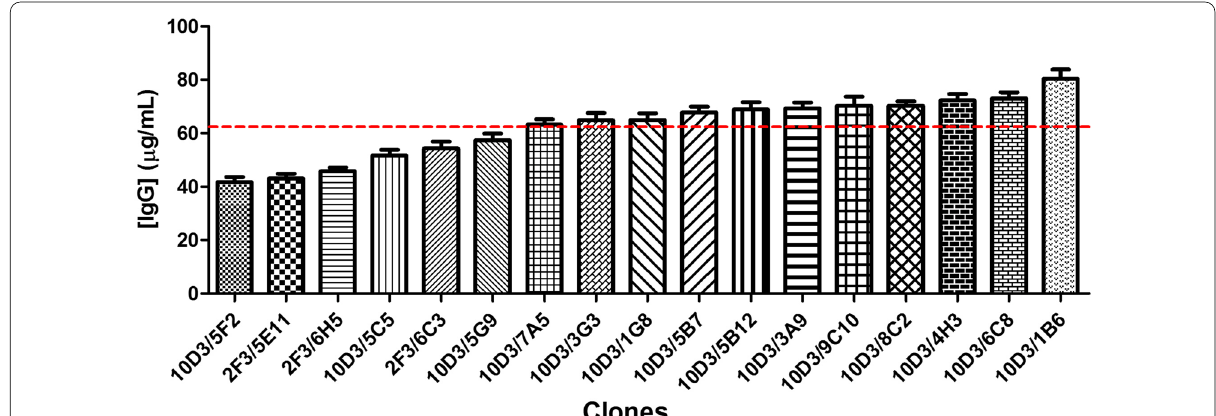
Fig. 7 IgG expression levels of trastuzumab‑expressing clones in chemically defined, protein‑free medium and shaking T‑flasks. Producing cells were seeded in 25 cm 2 T‑flasks at 0.4 x 10 6 cells/well in 10 mL of CP‑CHO‑CB5 medium. The experiment was performed in duplicates. T‑flasks were incubated at 37 °C in the presence of 5% CO 2 in vertical position and after 10 days cell culture supernatant was removed to quantify human IgG‑expression levels by ELISA. To quantify the expression levels, a standard curve was made using known amount of trastuzumab. The data correspond to mean SD. The discontinuous line indicates the average level of IgG for all the evaluated ±